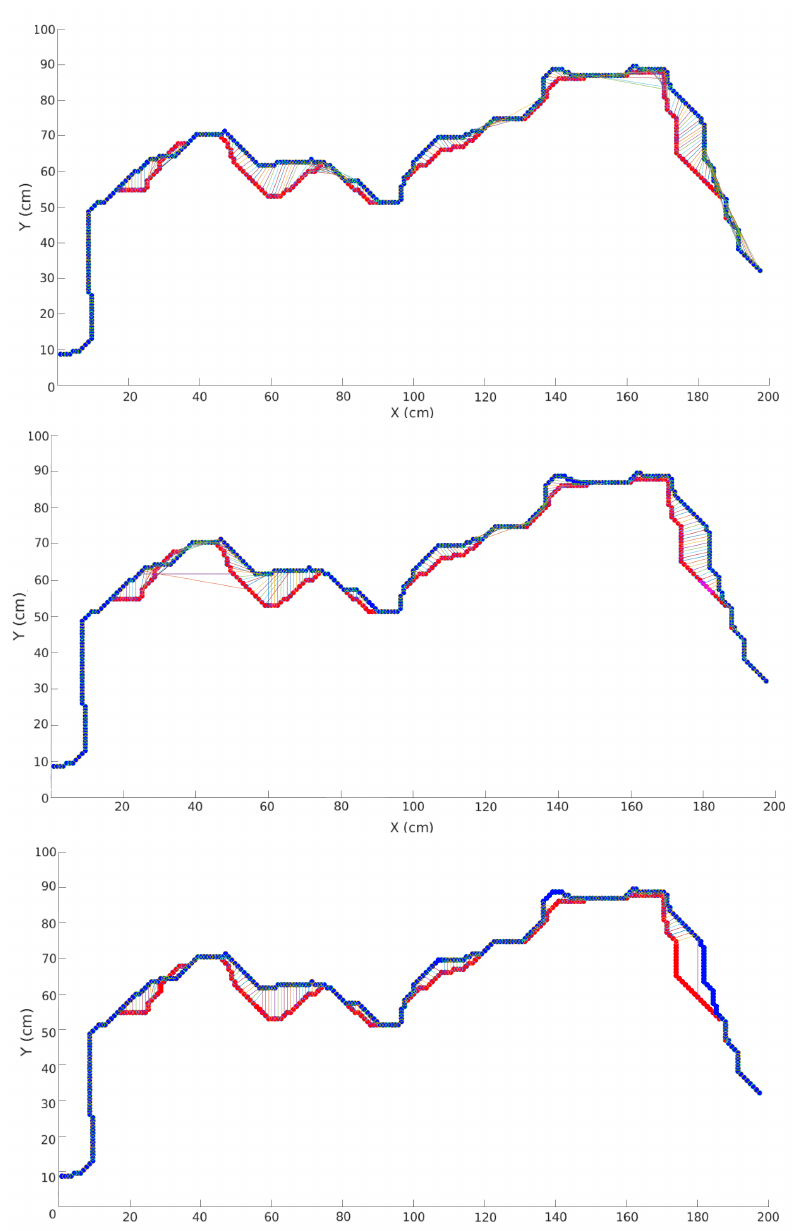
Figure 12. ( Top ): Displacement vectors using a subdomain length of 10 cm. ( Middle ): Displace- ment vectors using a subdomain length of 90 cm. ( Bottom ): Displacement vectors using a subdo- main length of 48.3 cm as determined in Figure 11. Connections formed with 0 weight points are not